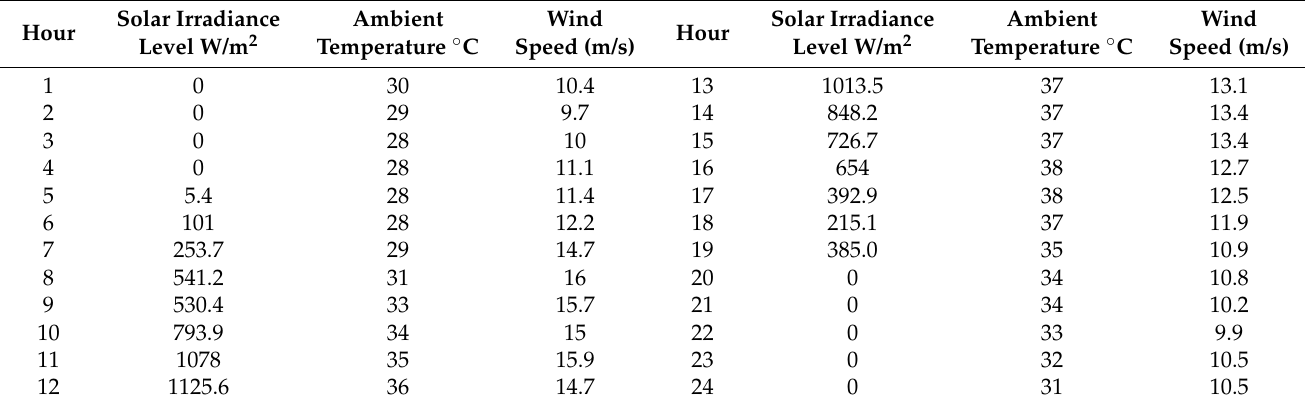
Table 12. Hourly solar irradiance level, ambient temperature, and wind speed.